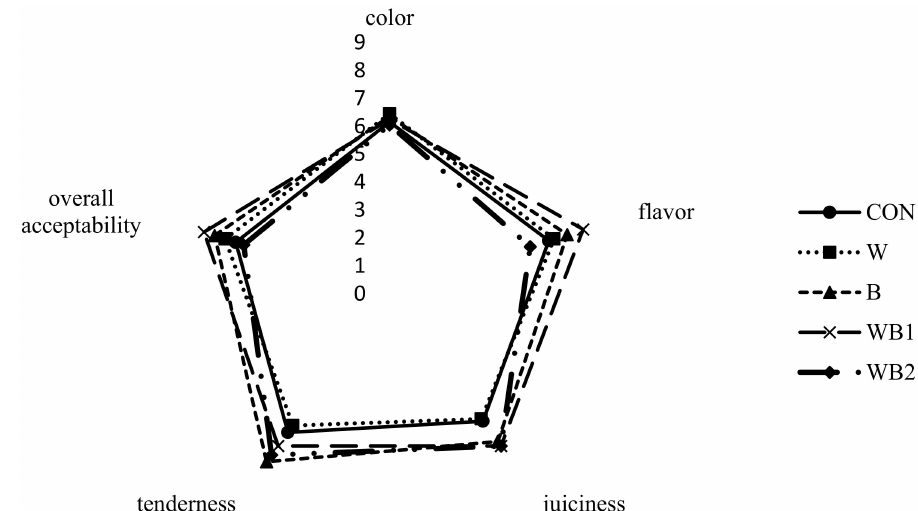
Figure 5. E ff ect of Boswellia serrata and whey powders on the sensory evaluation of pork patties. CON ( • ), control (no additive(s)); W ( (cid:4) ), addition of 2% whey powder; B ( (cid:78) ), addition of 0.5% B. serrata powder; WB 1 ( × ), addition of 2% whey powder and 0.5% B. serrata powder; WB 2 ( (cid:7) ), addition of 2% whey powder and 1% B. serrata